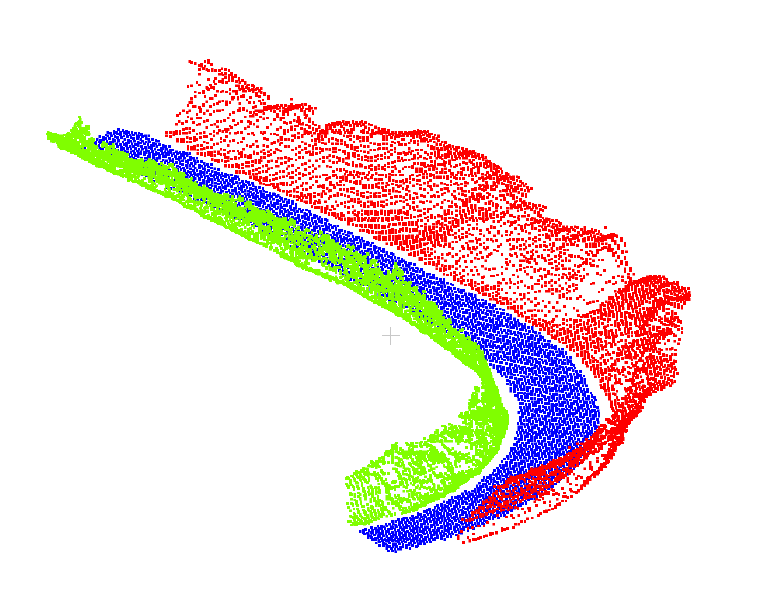
Figure 7: Roadside points segmentation result